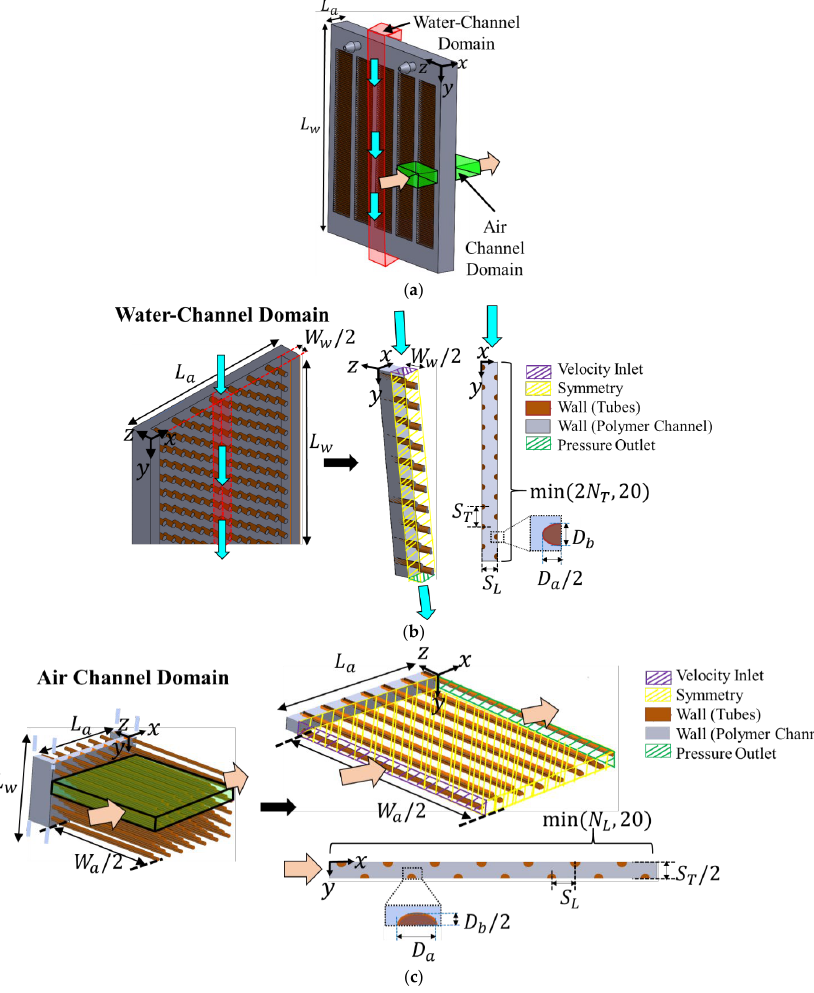
Figure 5. Domain simplifications: ( a ) entire iCMHX domain; ( b ) simplification to water-side do- main; and ( c ) simplification to air-side domain.